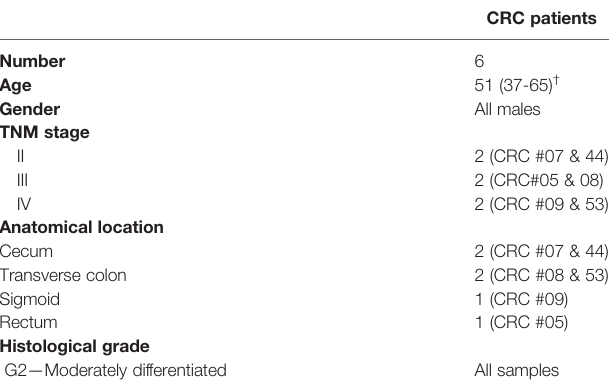
TABLE 1 | Characteristic features of study